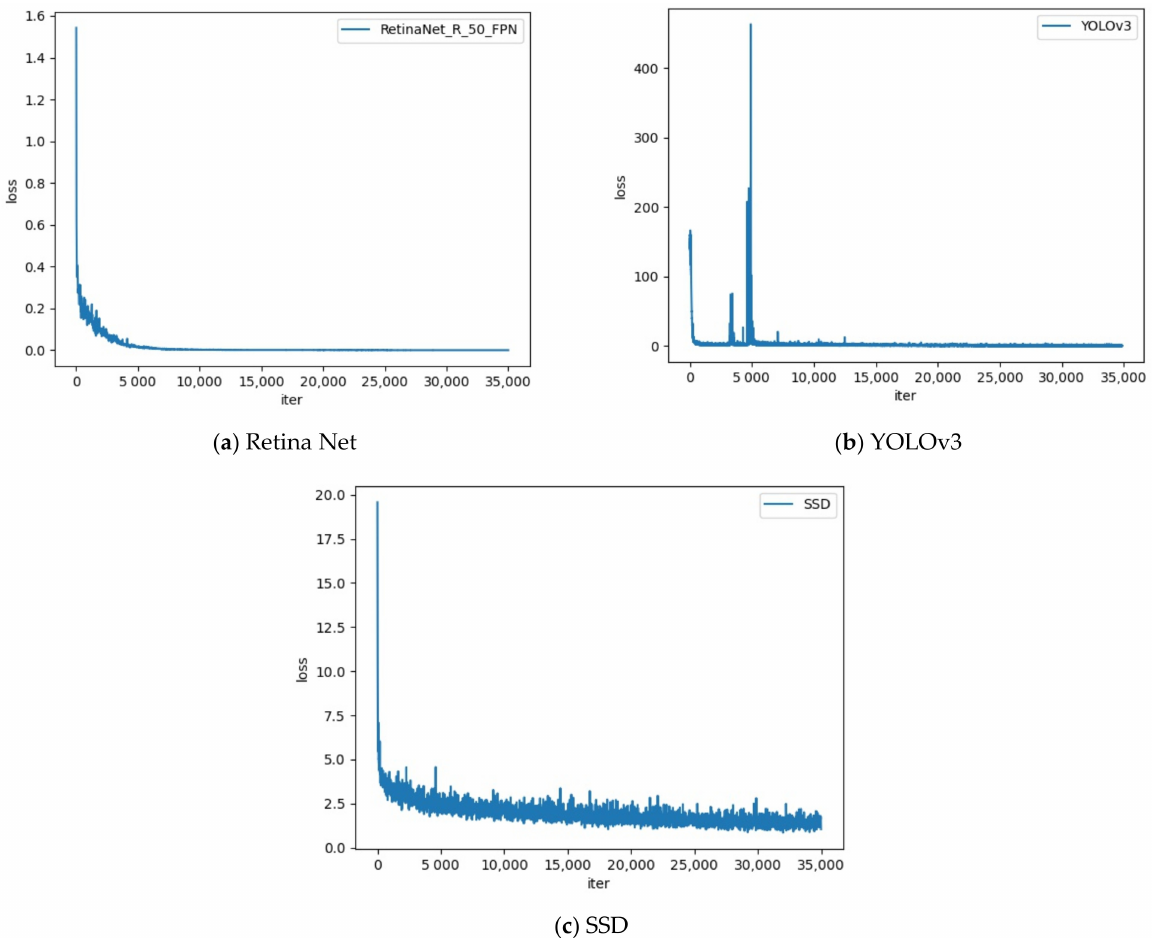
Figure 13. Training loss for one-stage method